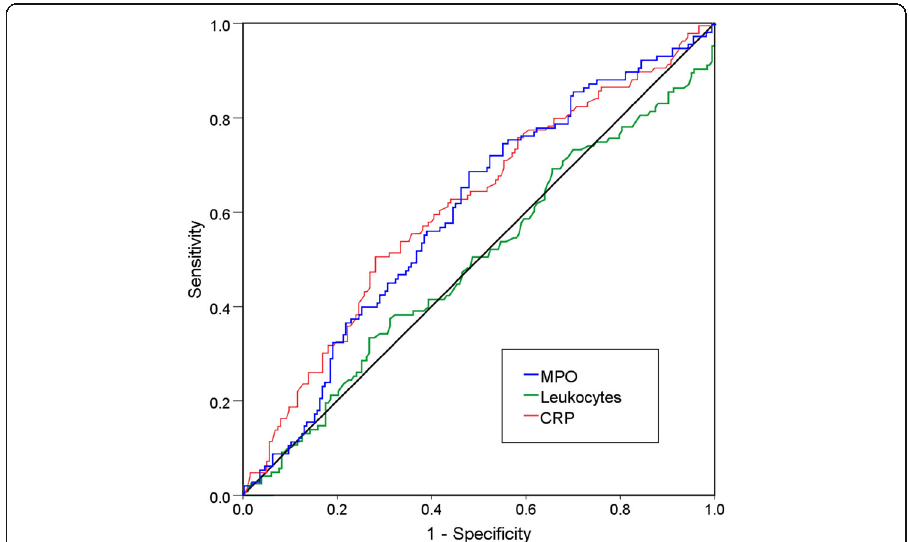
Fig. 2 ROC curves of MPO, CRP, and leukocytes in relation to sepsis. MPO myeloperoxidase, CRP C-reactive protein. MPO and CRP are both related to sepsis with an AUC 0.603 (CI 0.539 – 0.668) and AUC 0.636 (CI 0.573 – 0.699). Leukocytes have no discriminative